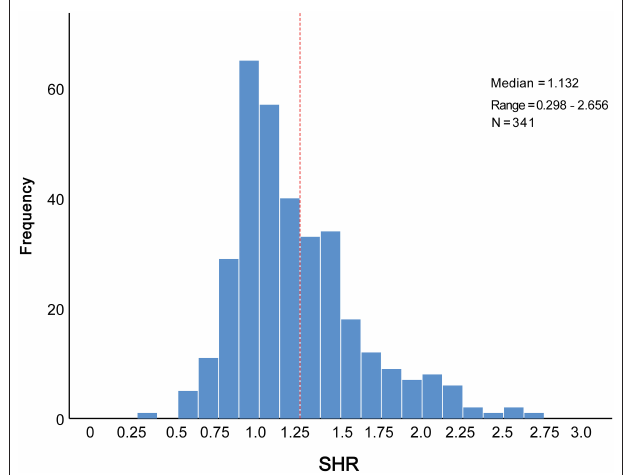
FIGURE 1 | Distribution of SHR levels in the elderly patients with AMI. AMI, acute myocardial infarction; SHR, stress hyperglycemia ratio.